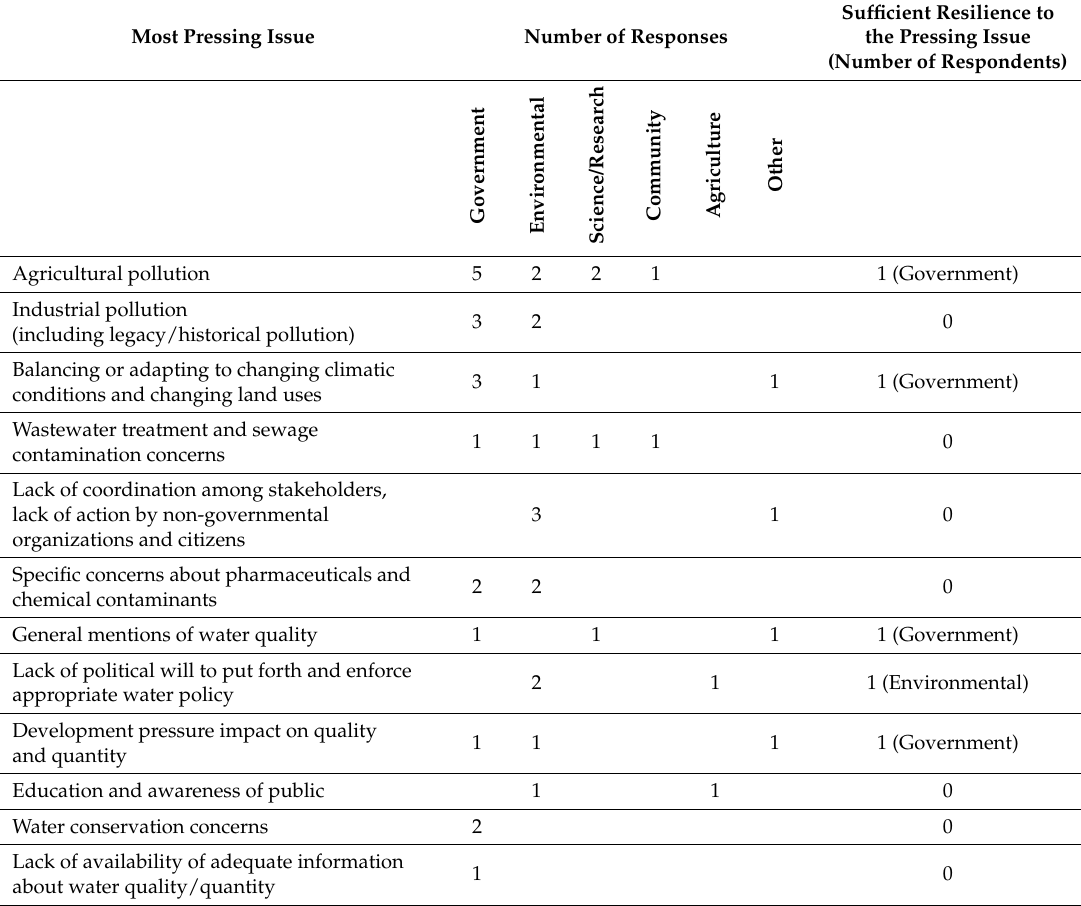
Table 3. Most pressing issues identified by respondents in the Niagara River